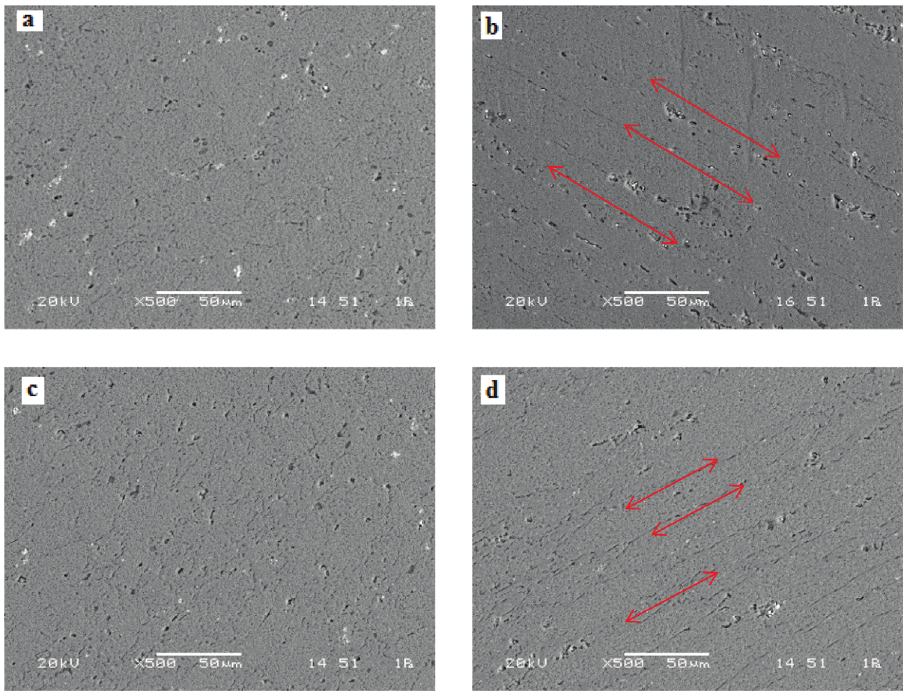
Figure 3: The SEM microstructure of the ECAPed AA7075: one passed (a), two passed (b), three passed (c) and four passed